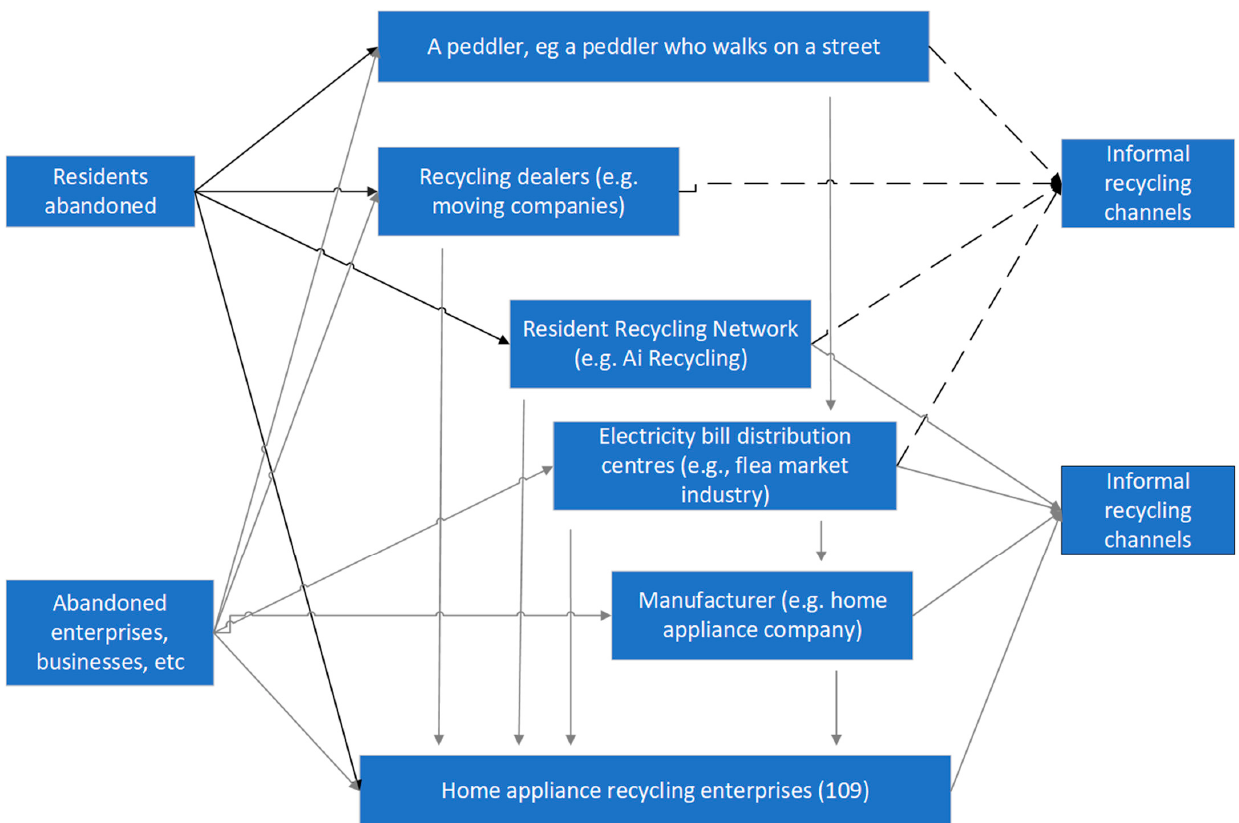
Figure 11. Channels of WEEE recovery in China.